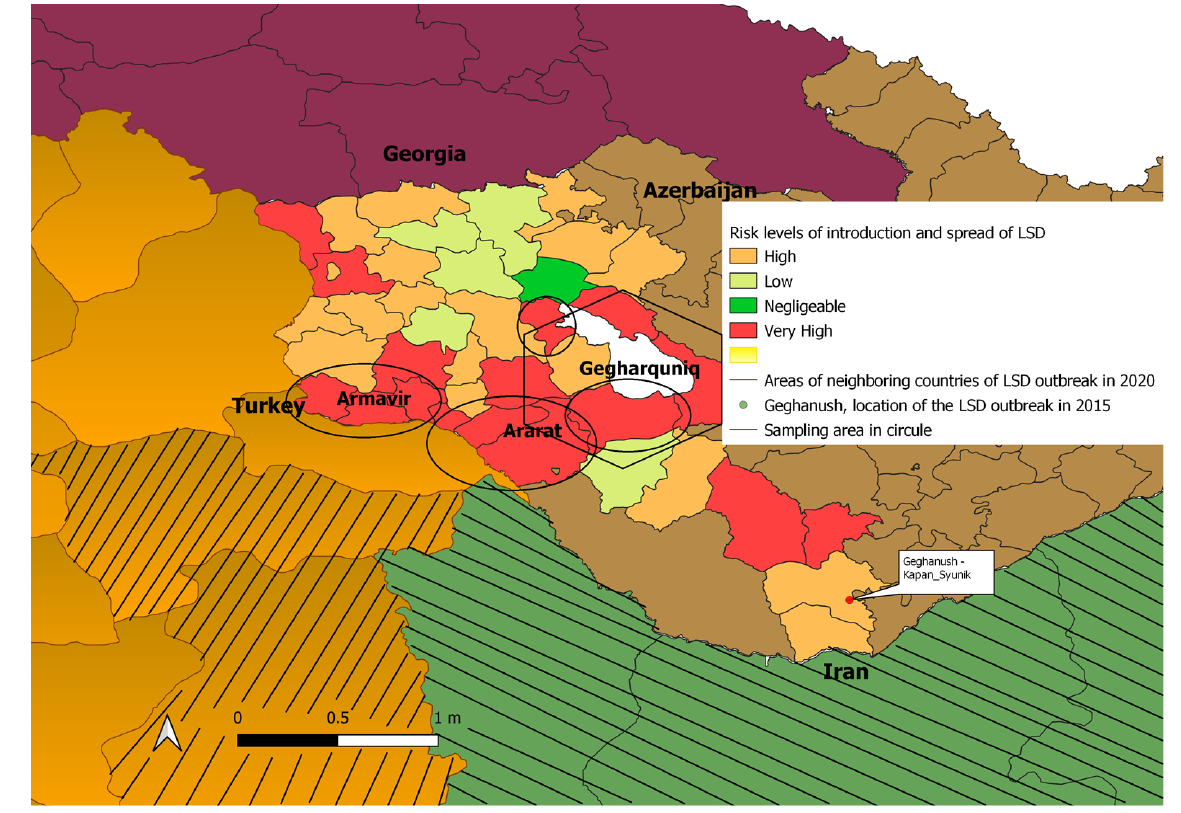
Figure 2. Risk levels of LSDV incursion and locations of sampling and vaccination in Armenia in 2020 with neighboring countries showing outbreaks at that time.